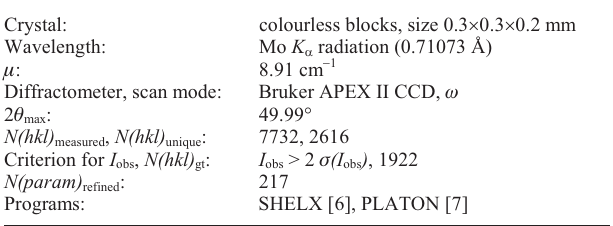
Table 1. Data collection and handling.